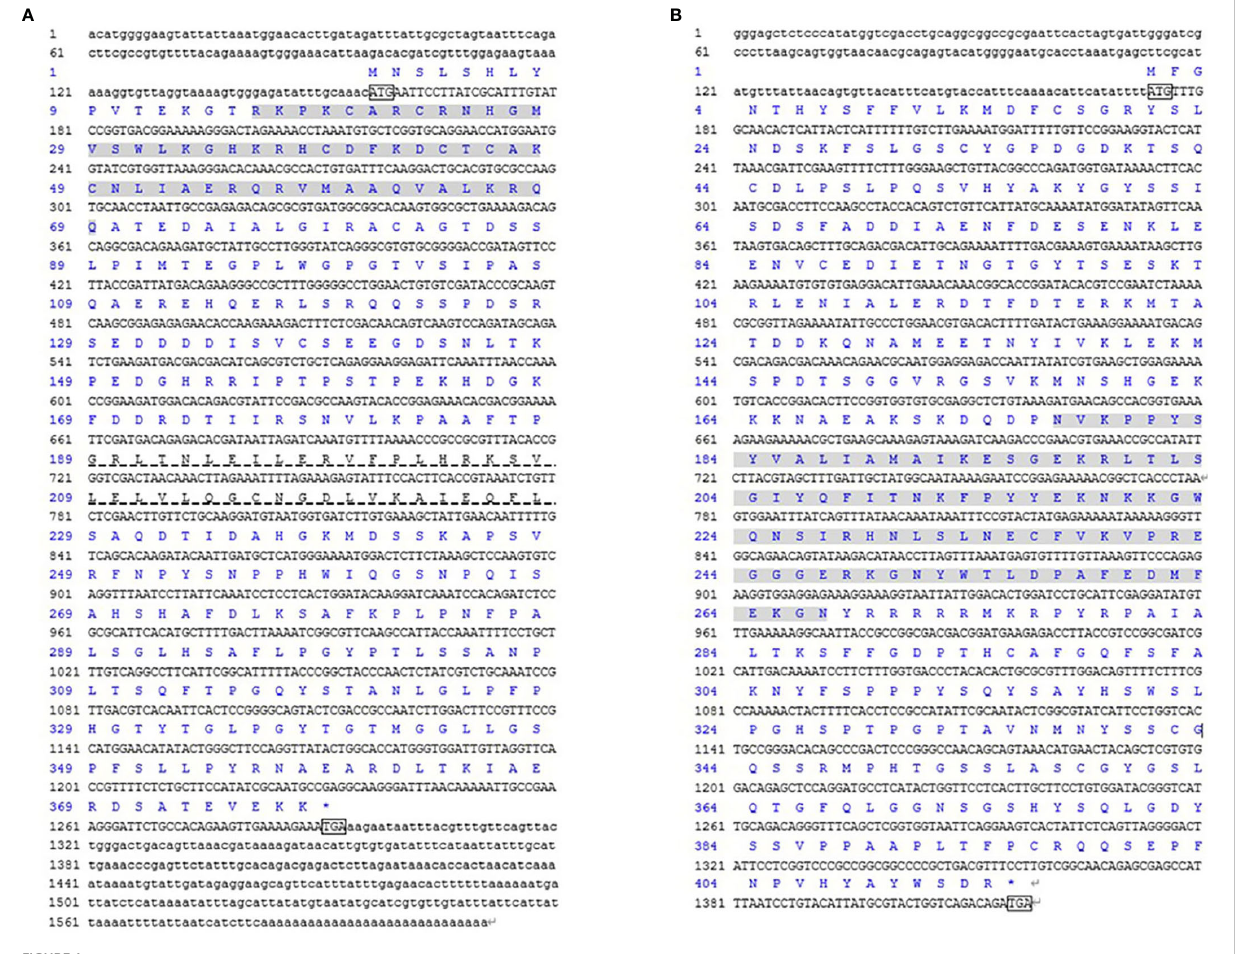
FIGURE 1 The DMRT3 (A) and FOXL2 (B) cDNA and deduced amino acid sequence of C. sinensis . The ATG/TGA indicated by the box starts codon/stop codon; shaded regions represent the DM domain and the FH domain, respectively. The DMA domain was indicated by virtual